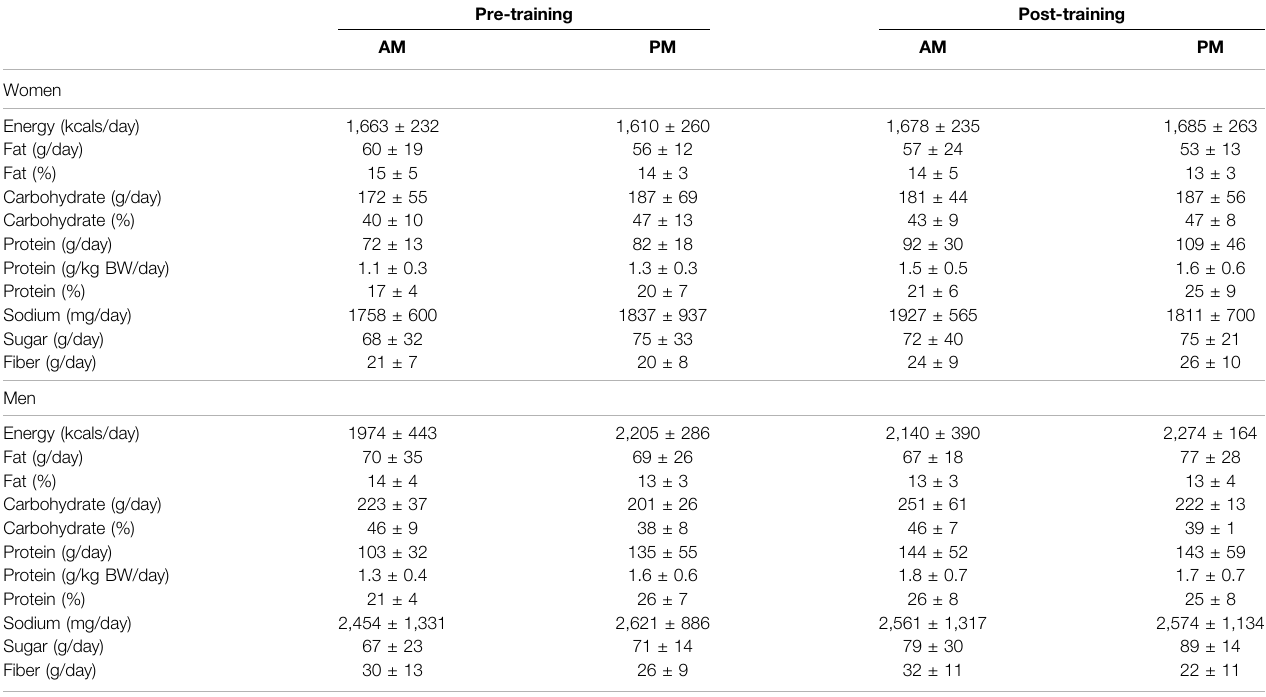
TABLE 2 | Dietary intake changes between AM vs PM exercisers during the 12-week RISE Exercise Intervention for women and men.